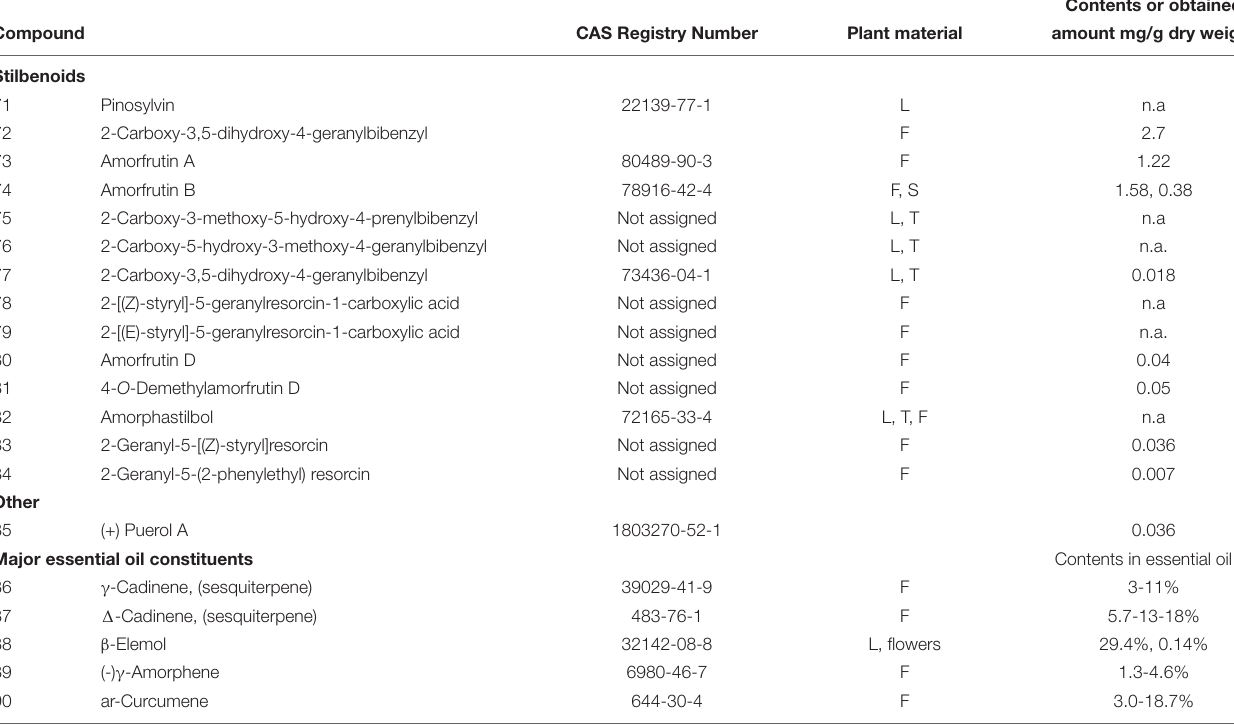
TABLE 3 | Stilbenoid compounds, puerarol, and examples of major essential oil constituents from various parts of Amorpha fruticosa